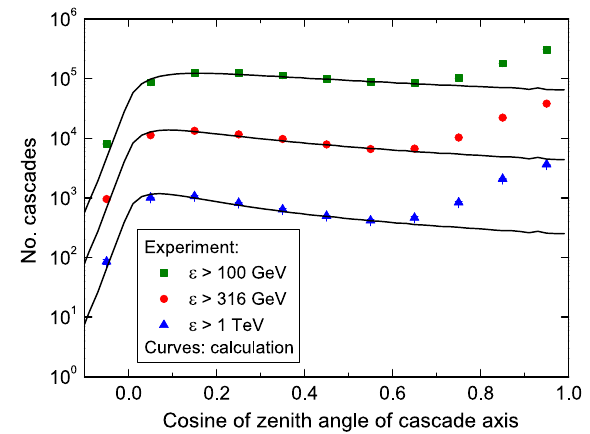
Figure 7. Zenith-angular distributions of cascades.